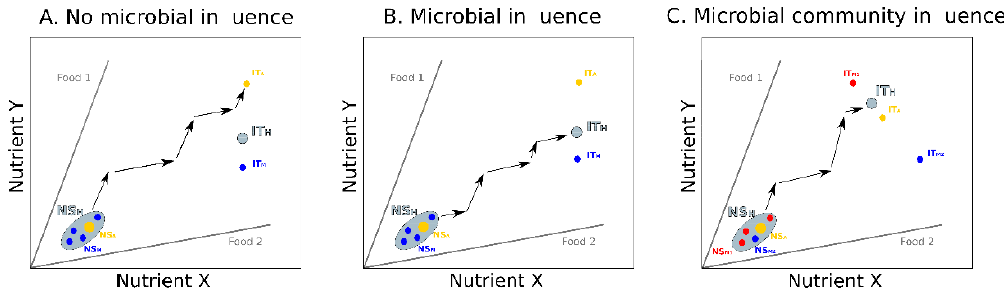
Figure 2. Influence of the gut microbiota on host nutrition. In these hypothetical examples, hosts and microbes are represented in a common nutrient space defined by two nutrients. Food types (grey lines) are defined by their ratio in nutrients X and Y. The animal host (yellow dot) and the microbes (blue and red dots), together forming the holobiont (grey surface), are charatcerized by their own nutritional states (animal: NS A ; microbe: NS M ; holobiont: NS H ) and intake targets (animal: IT A ; microbe: IT M ; holobiont: IT H ). ( A ) The animal is colonized by a single microbe type that does not influence its feeding behavior. The animal can reach the IT A by combining its intake of the two complementary foods (black arrows). The optimal IT H for both holobiont components is never reached. ( B ) The animal is colonized by a single microbe type that influences its feeding behaviors. The animal can reach an IT H that falls between IT A and IT M depending on the relative influence of the host and the microbes on feeding decisions. ( C ) The animal is colonized by two microbe types (assemblage of microbes) that both influence its feeding behavior. The animal can reach an IT H that falls between IT A , IT M1 and IT M2 depending on the relative influence of the host and the two microbe types on feeding decisions. In this example, microbe type 1 has a stronger influence on the feeding decisions of the host than microbe type 2. The same logic can be extended to richer microbial communities where a global effect of the microbial community can affect the animal feeding behavior.